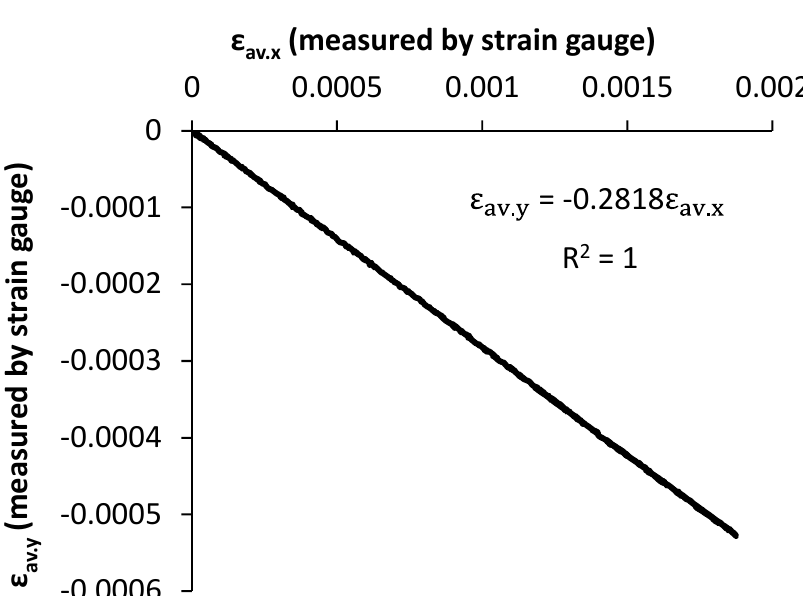
Figure 5. The longitudinal average strain ( ε av.x ) versus the transversal average strain ( ε av. y ) within Phase 1. The strains were measured using strain gauges.